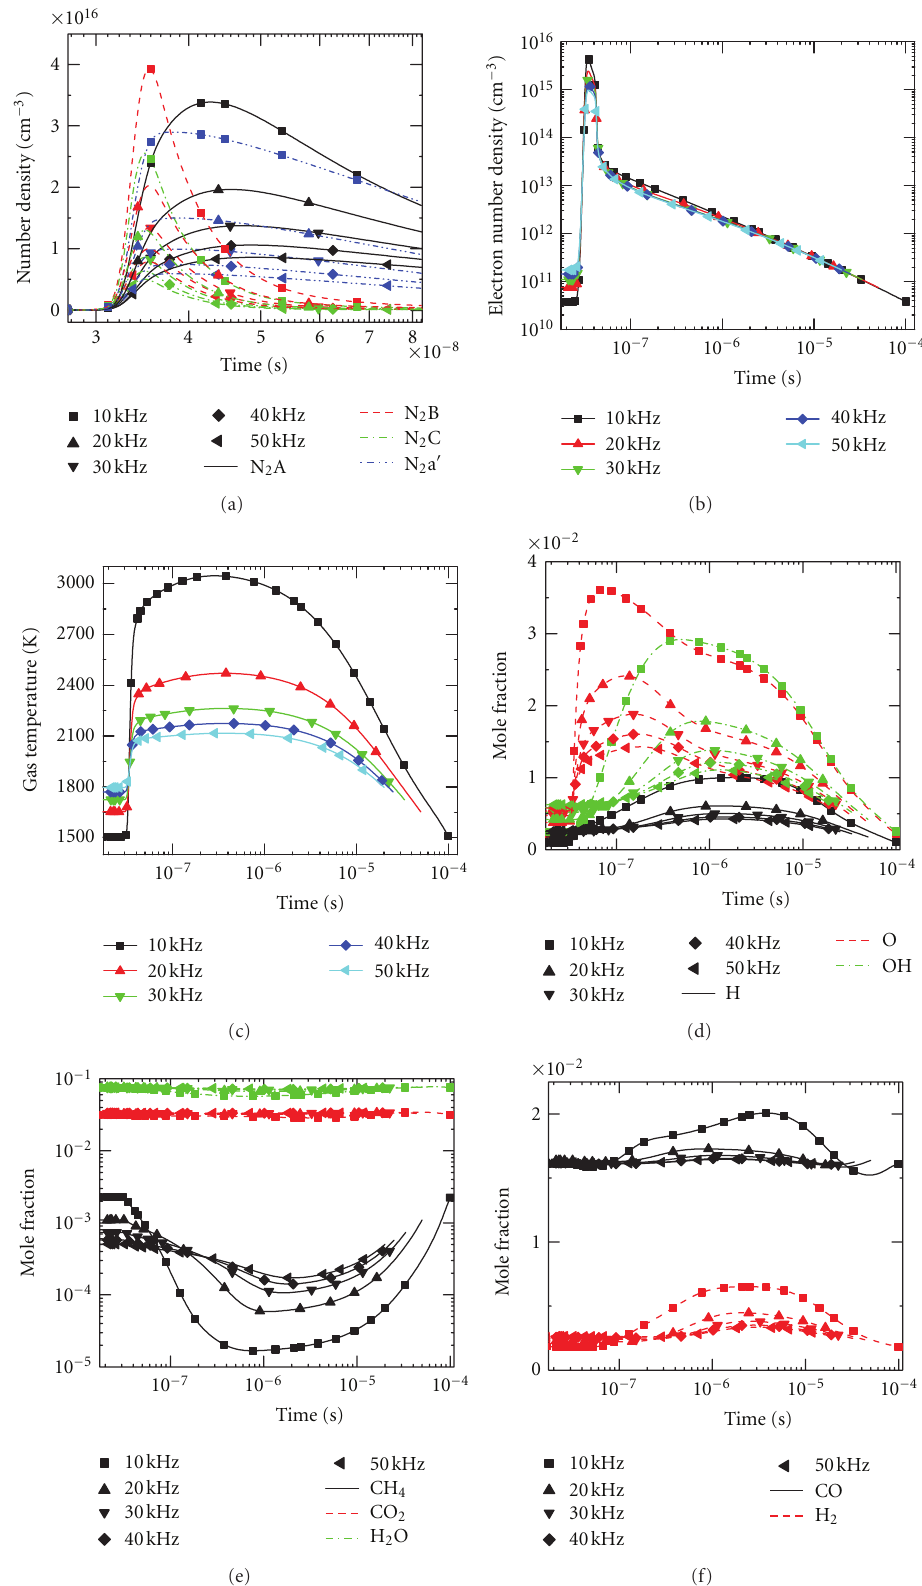
Figure 2: Kinetic evolution of (a) excited electronic states of N 2 (A, B, C, a (cid:2) ), (b) electron, (c) gas temperature, (d) radicals (O, H, and OH), (e) combustion major species (CH 4 , CO 2 , and H 2 O), and (f) minor species (H 2 and CO) within the discharge region during a single period when the pulse width is 9ns and the repetition rates are 10kHz, 20 kHz, 30kHz, 40 kHz, and 50